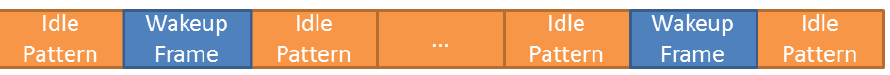
Figure 14. Complete frame format of VLC communication. Table 2. Illumination Level of the Frame Stream Using Different Levels of Dimming.